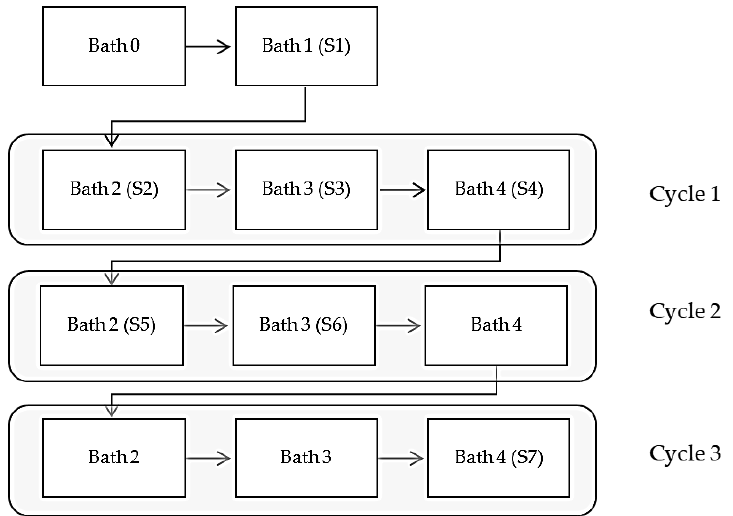
Figure 1. Flowchart depicting stages of the plating process and where along the process, samples were collected.